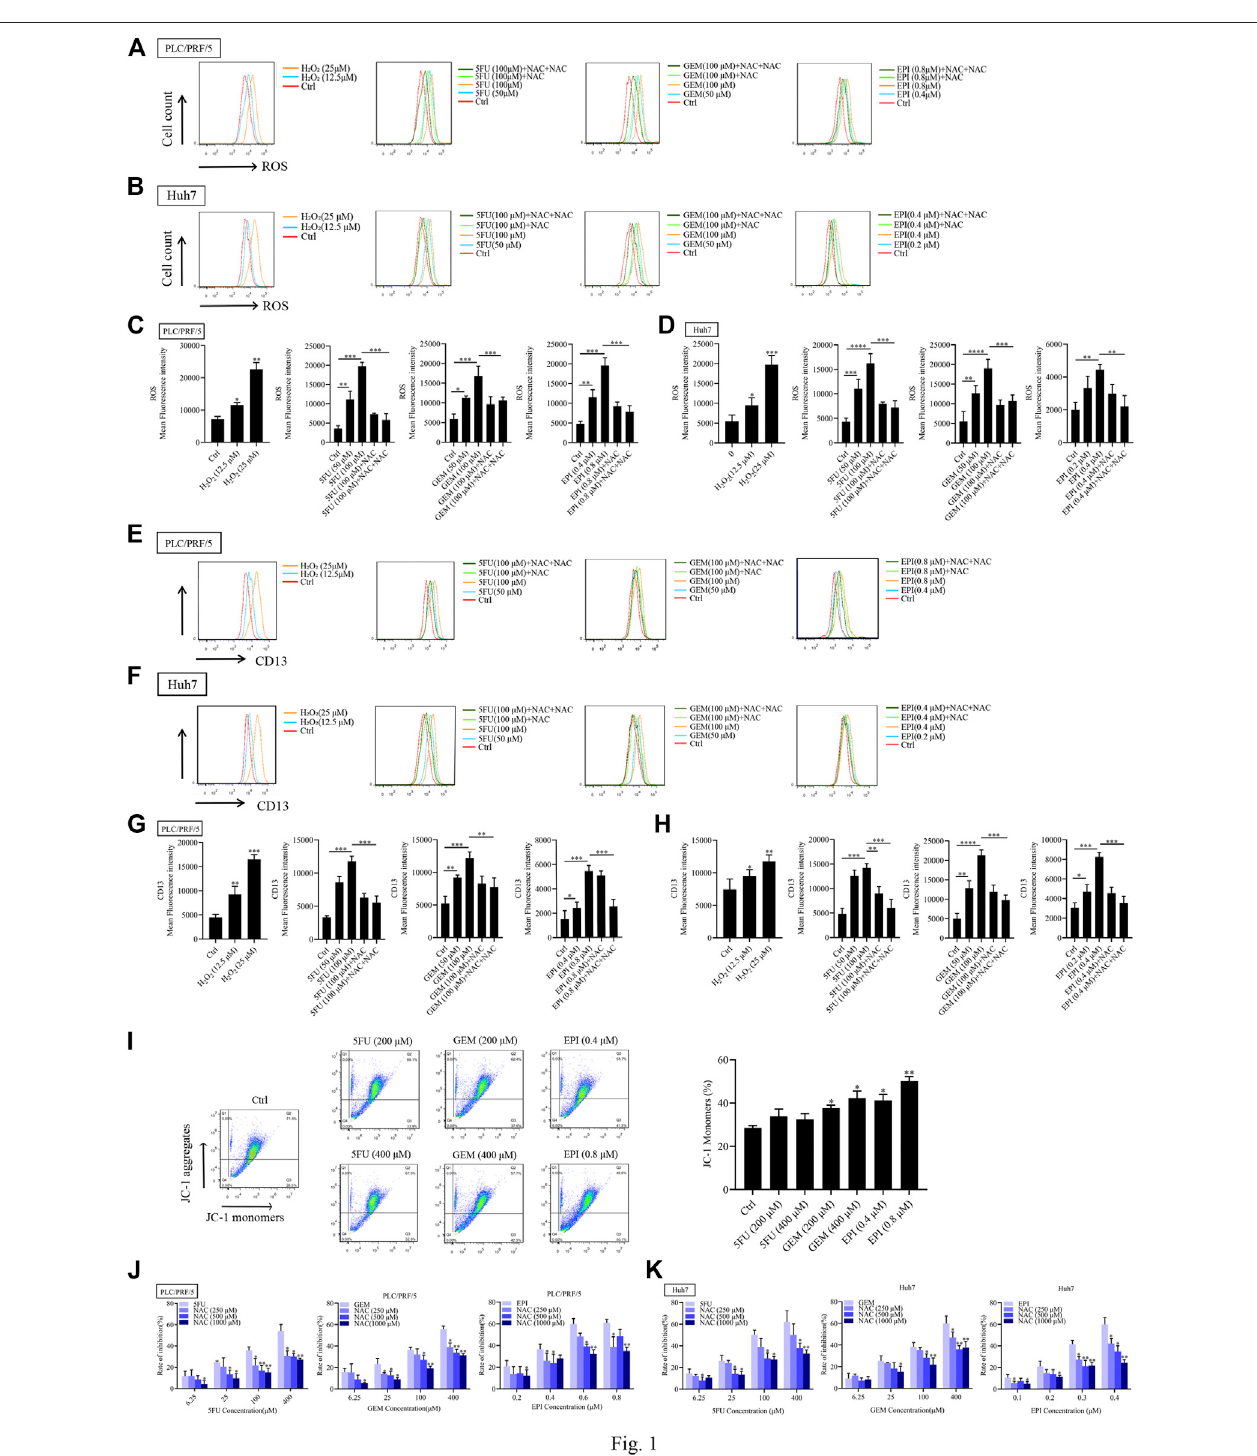
FIGURE 1 | Chemotherapeutic drugs upregulates ROS and induce CD13 expression. Effect of chemotherapeutic drugs on ROS levels. PLC/PRF/5 and Huh7 cells were treated with H 2 O 2 or 5FU, GEM and EPI combined with NAC (500 μ M) for 48 h. (A – D) The intracellular ROS levels (E – H) the expression of CD13 detected by fl ow cytometry. Data are presented as mean ± SEM ( n (cid:2) 3). * p ≤ 0.05, *** p ≤ 0.001. (I) The mitochondrial membrane potential measured by fl ow cytometry in PLC/PRF/5 cells treatedwith5FU,GEM,andEPI.Dataarepresentedasmean ± SEM( n (cid:2) 3).* p ≤ 0.05,** p ≤ 0.01. (J,K) CellproliferationwasmeasuredbyEdUassayinPLC/PRF/5and Huh7 cells treated with 5FU, GEM and EPI, or combined with NAC for 48 h. Data are presented as mean ± SEM ( n (cid:2) 3). * p ≤ 0.05; ** p ≤ 0.01.